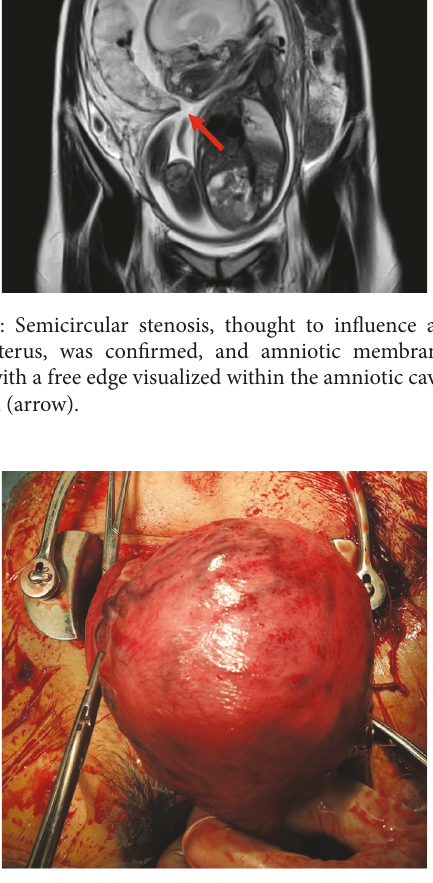
of gestation, she underwent cervical dilatation and uterine curettage.